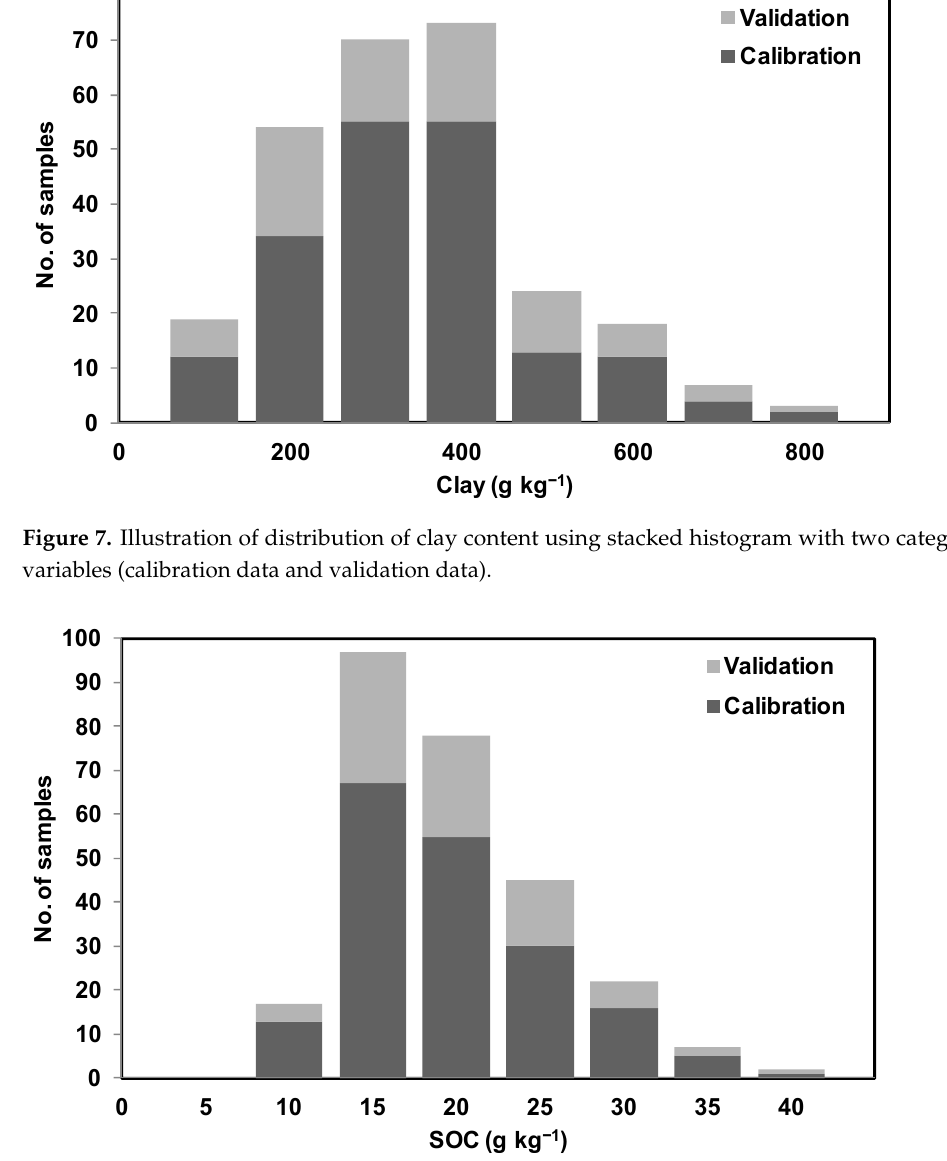
Figure 8. Illustration of distribution of SOC content using stacked histogram with two categorical variables (calibration data and validation data). Table 3. Statistical results of PLSR with leave-one-out cross-validation trained on mid-IR calibration dataset examples and tested on mid-IR validation dataset